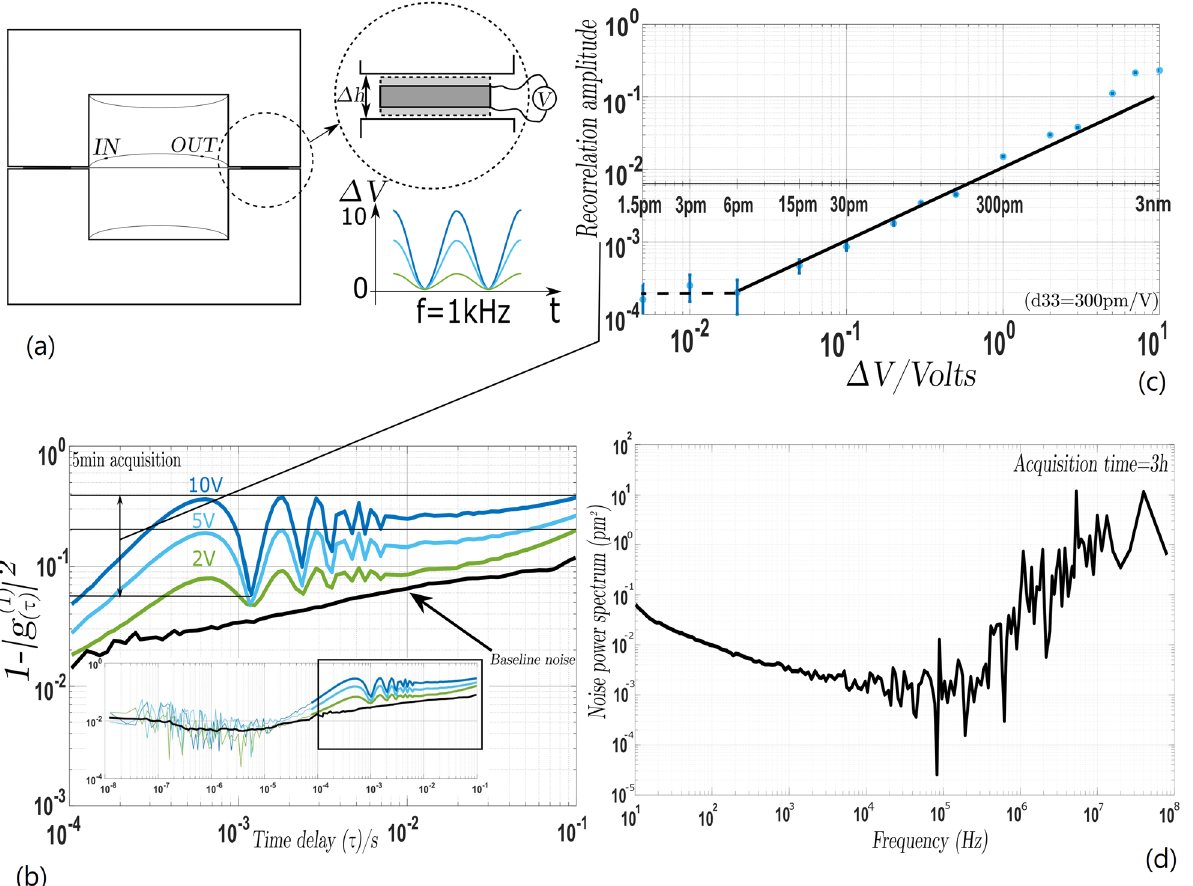
Fig. 3 Interferometer response to harmonic cavity shape deformations. a Home-made cylindrical quartz cavity (height h c = 6 cm, diameter φ c = 5 cm, wall thickness 3 cm). Two voltage-driven piezo actuators (thickness 1 mm, placed at a 120° angle) are inserted between the two halves of the cavity. A sinusoidal 1 kHz voltage is fed to the piezo actuators to deform the cavity. b Intensity decorrelation of the speckle intensity ½ 1 (cid:2) j g ð 1 Þ ð τ Þj 2 (cid:4) as a function of time delay τ for voltage amplitudes of 10, 5, and 2 V. The noise baseline is the standard deviation σ ð τ Þ of the auto-correlation function for the j g ð 1 Þ j 2 unperturbed cavity (black line). The acquisition time was 5 min with 300 mW laser input power, and experiments were averaged over 10 repetitions. c Recorrelation amplitude obtained from b as a function of the piezo voltage and actuation amplitude. The acquisition time was 5 min for voltages above 1 V and 30 min below. The error bars represent the uncertainty at which the recorrelation amplitude can be read, as per the noise intensity baseline. d Noise power spectrum of the system expressed in pm 2 as a function of frequency, for a 3-h acquisition